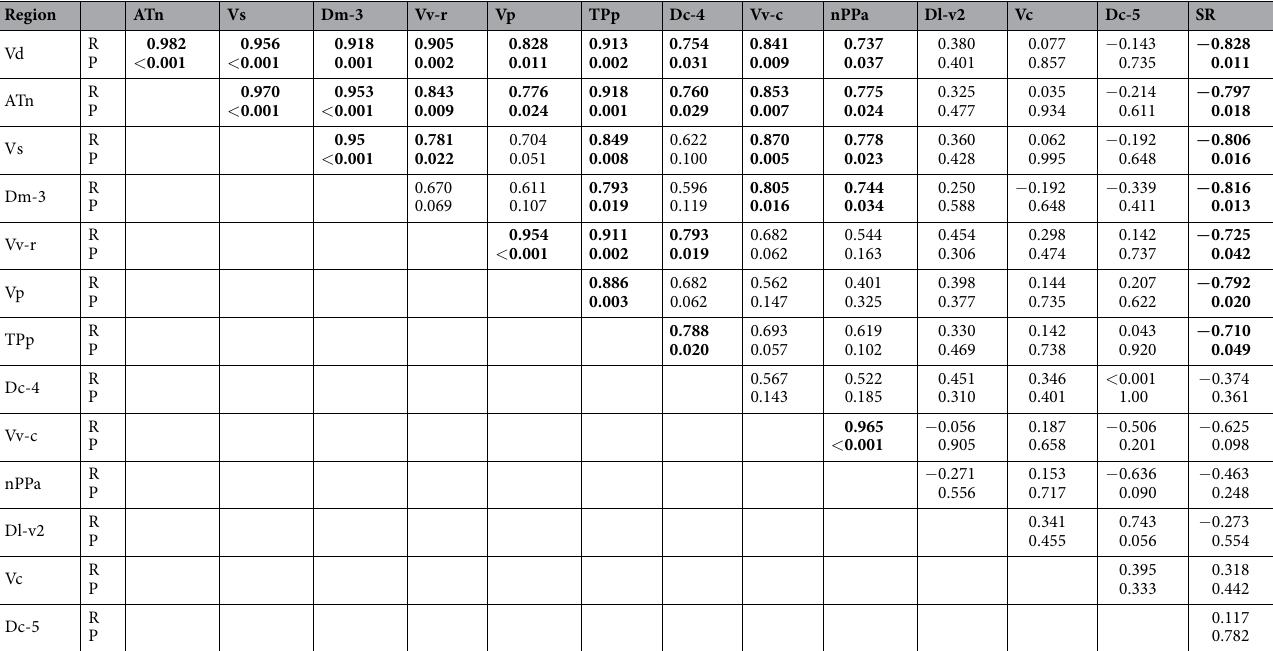
Table 2. Pearson correlation values of pS6 staining in each brain nucleus correlated with all other regions. Pearson correlation coefficients ( R ) were used to create the heatmap in Fig. 6a. Bold indicates significance at P <